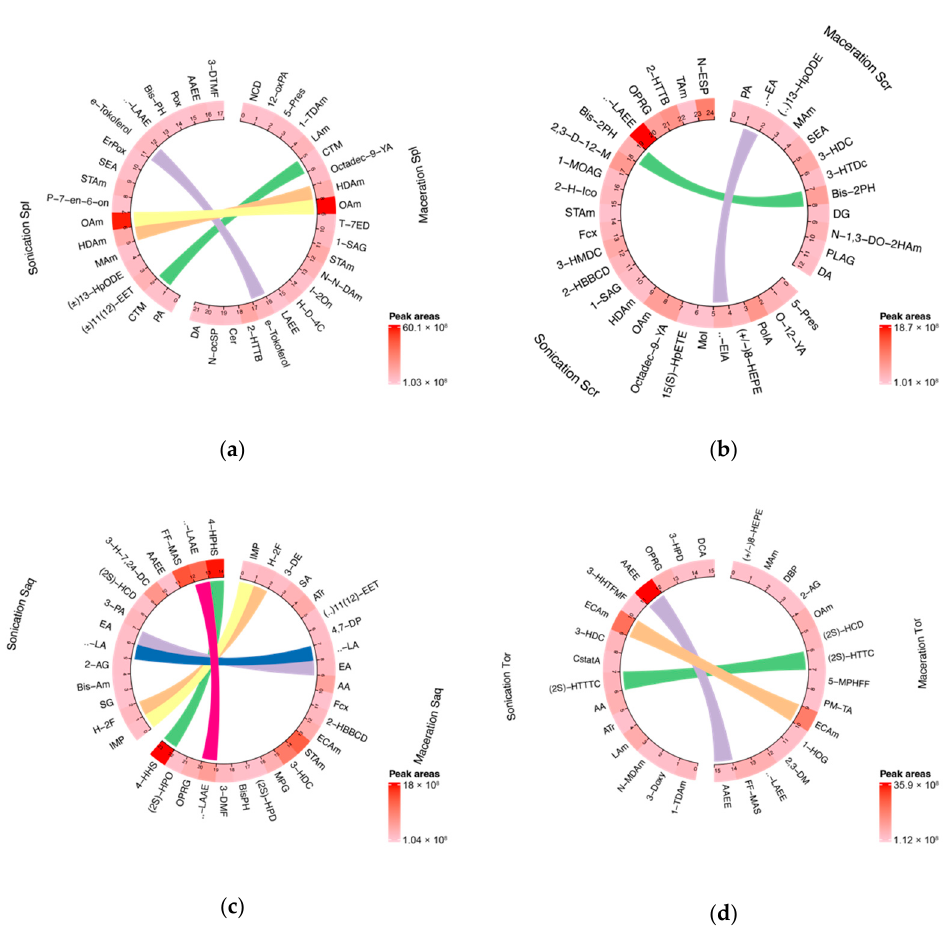
Figure 1. Circular plot showing the variability of chemical compounds compositions in brown algae extracts in two different extraction methods, sonication or ultrasonic-assisted extraction (UAE), and cold maceration. Each plot consists of compounds found in algae that have been extracted with two different methods that are shown side by side on the circular plot. The linear line between each circular plot corresponds to the identic compound found in both type of extraction method. ( a ) Sargassum polycystum ; ( b ) Sargassum cristaefolium ; ( c ) Sargassum aquifolium ; ( d ) Turbinaria ornata ; Spl = Sargassum polycystum ; Scr = Sargassum cristaefolium ; Saq = Sargassum aquifolium ; Tor = Turbinaria ornata . Abbreviations and complete datasets could be seen in Supplementary Materials: Table S1 (a– h).